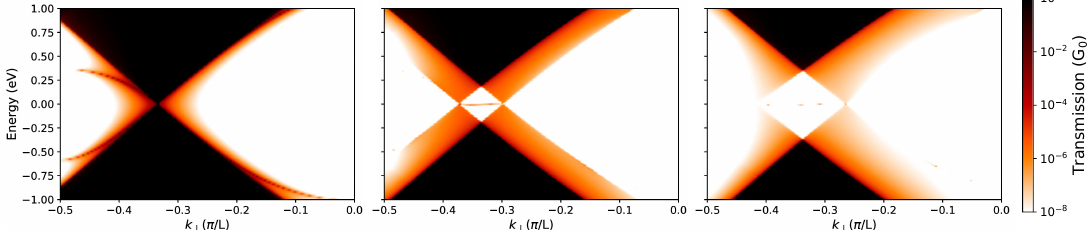
Figure 2. Strain effects on the electronic transport through graphene grain boundaries. ( E − k ⊥ ) maps of transmission obtained for the class-I GB in Figure 1a with different uniaxial strain magnitudes: 0% ( left ), 3% ( middle ) and 6% ( right ), oriented with 45 ◦ with respect to BG axis. Reprinted and adapted with permission from reference